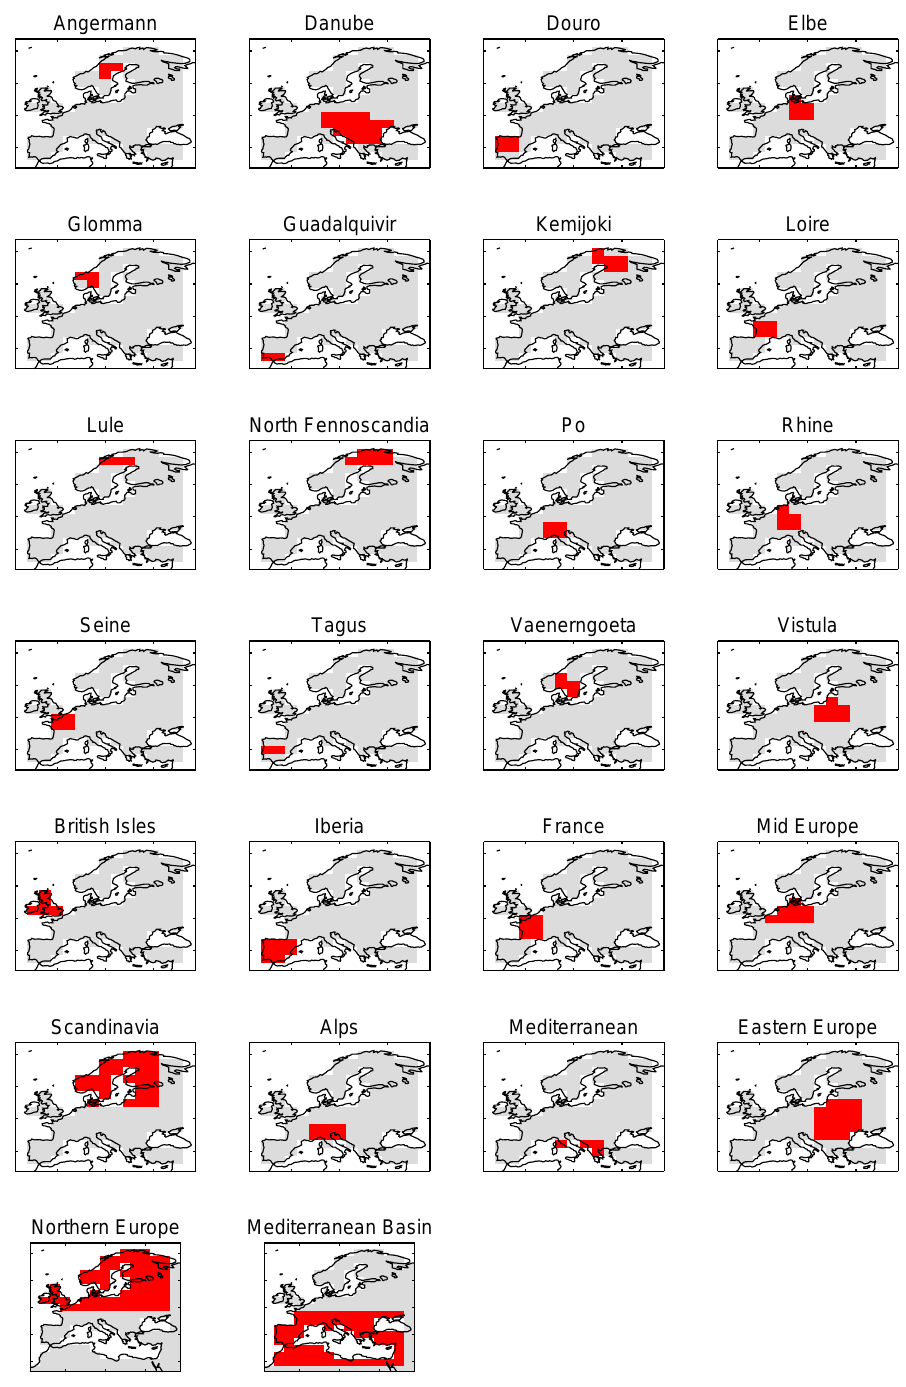
Fig. 4. HadCM3 representation of the aggregate European regions for which probabilistic projections are supplied.